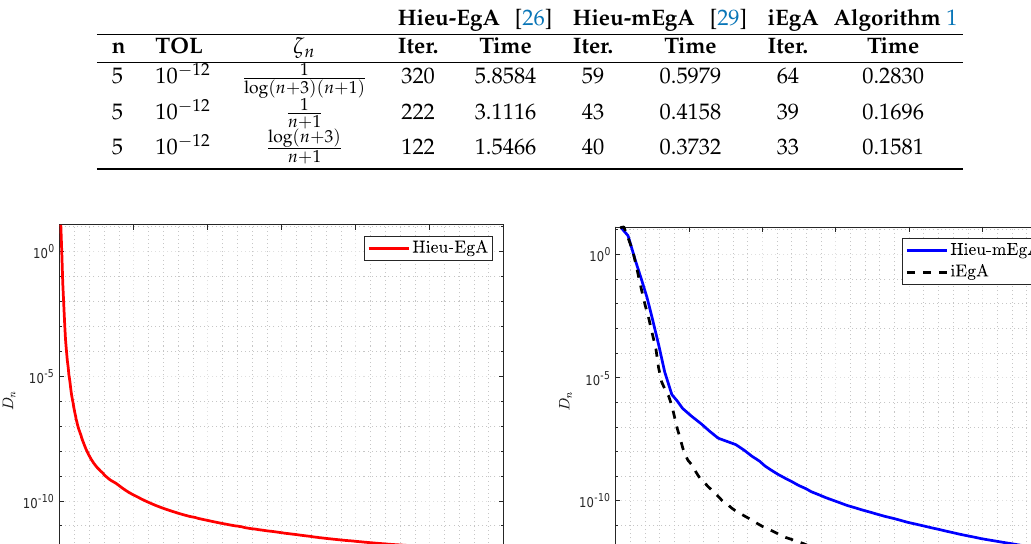
Figure 1. Example 1: Numerical comparison for Algorithm 1 while ζ n = 1